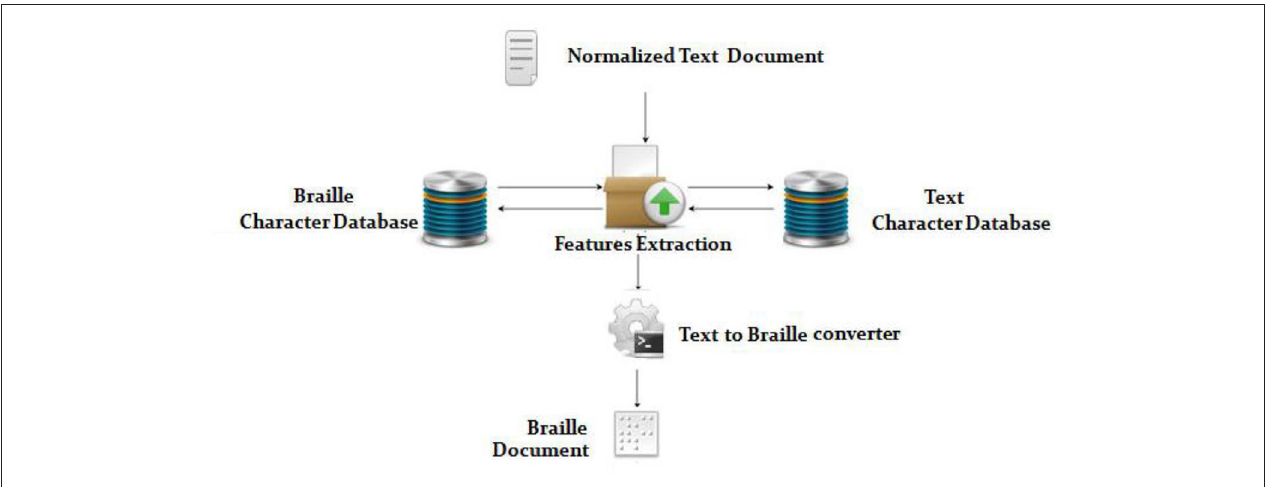
FIGURE 6 | Text to Braille Conversion.